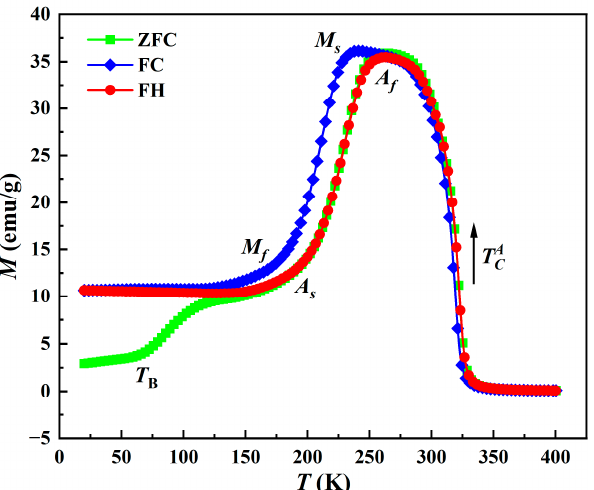
Figure 4. Temperature dependence of magnetization of the virgin sample measured under a magnetic field of 500 Oe.